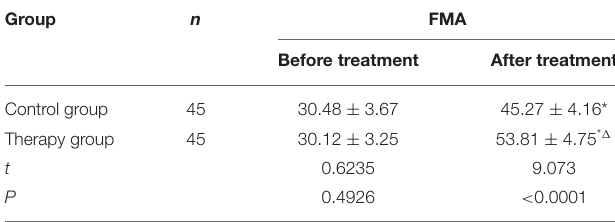
TABLE 3 | Comparison of FMA scores before and after treatment between the two groups (M ± S D,